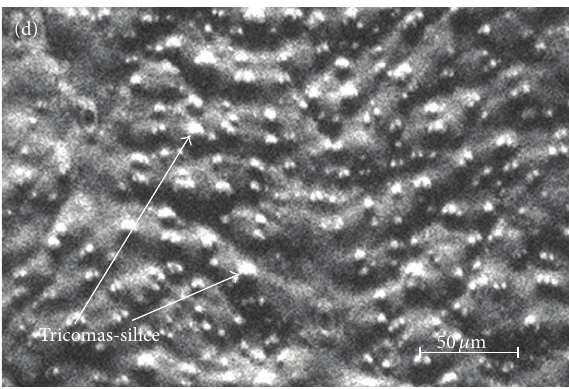
Figure 8: Micrograph of the external surface of GAKVB.